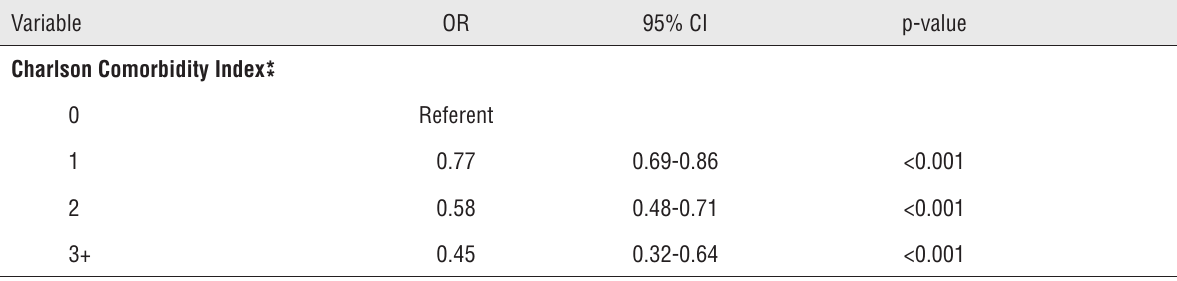
Table 4b - Odds ratios receipt of NACRC for patients with MIBC all Charlson Comorbidity Scores.